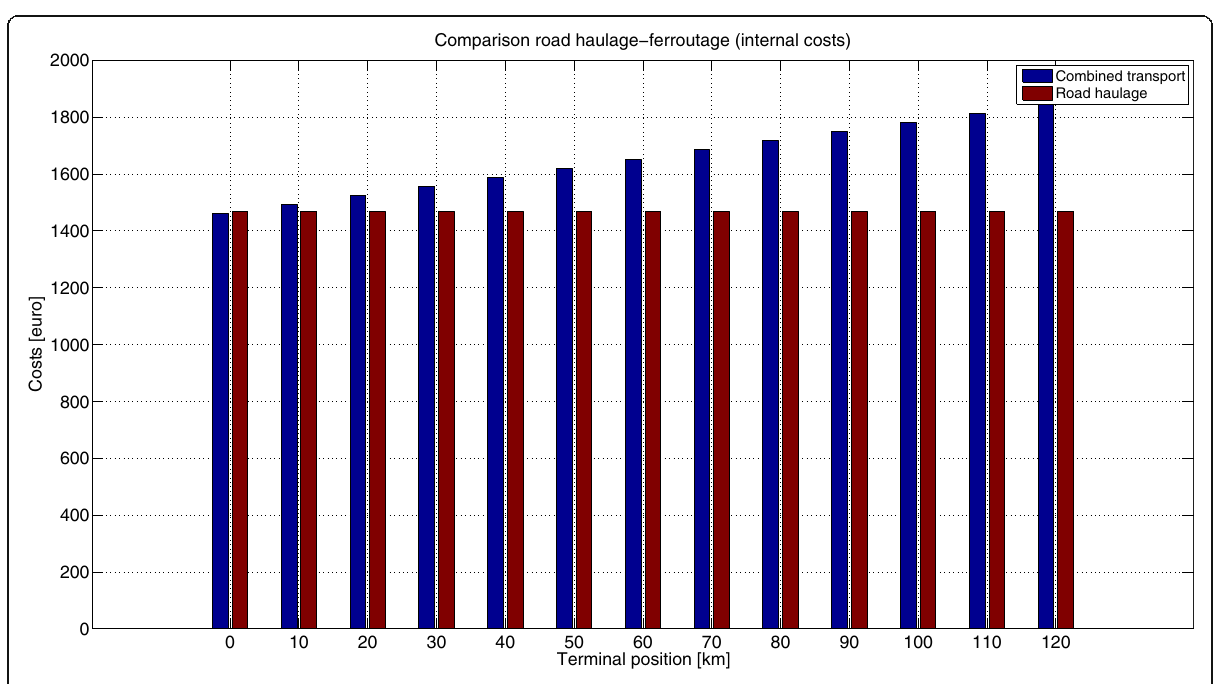
Fig. 11 Comparison of the internal